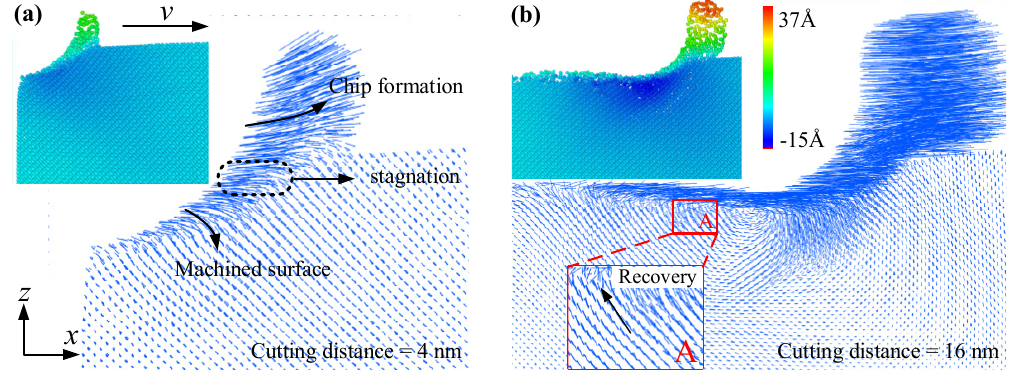
Vertical view Figure 4. The lateral bulge and surface morphology of machined SiC at cutting speed of ( a ) 100, ( b ) 200, and ( c ) 400 m/s. In general, the subsurface quality can also affect the service performance and life of the components. Thus, it is particularly important to analyze the machining-induced dam- age of SiC and optimize the nanometric machining technology. Figure 5 shows the effect